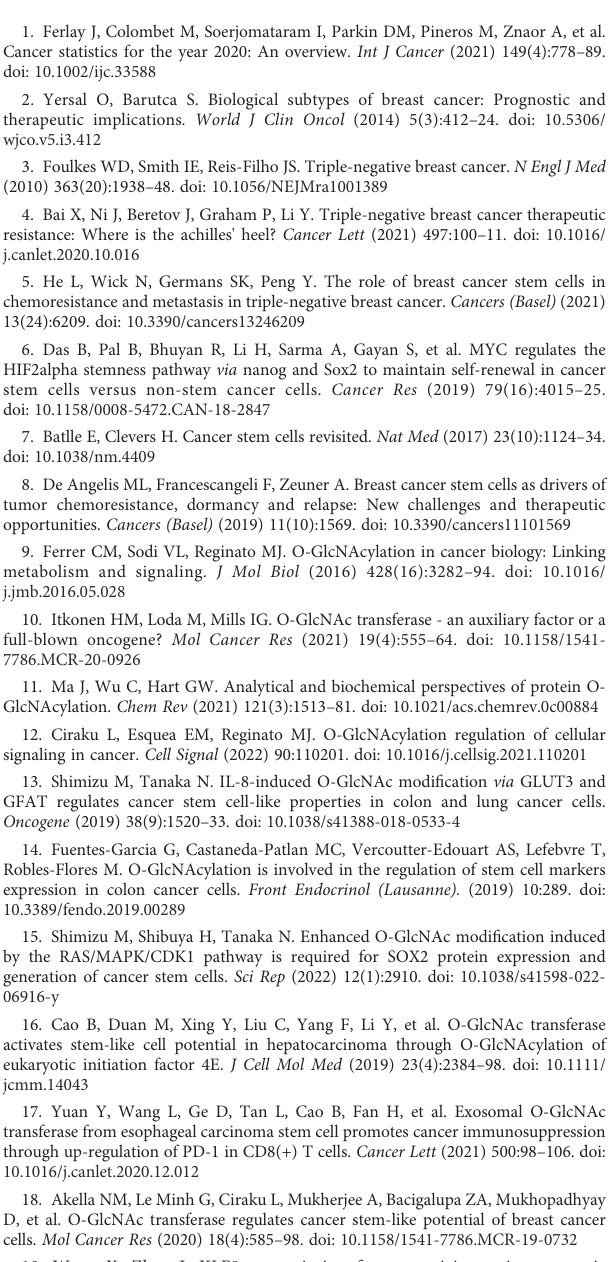
control shRNA or KLF8 shRNA as detected by immunoblot using indicated antibodies (corresponding to ). Student t test reported as mean ± SEM, *p<0.05. SUPPLEMENTARY FIGURE 5 Increased KLF8 expression associates with poor outcome of breast cancer. (A) Kaplan-Meier plot showing overall survival of all breast cancer patients with different level of KLF8 mRNA. (B) Kaplan-Meier plot showing overall survival of basal-type breast cancer patients with different level of KLF8